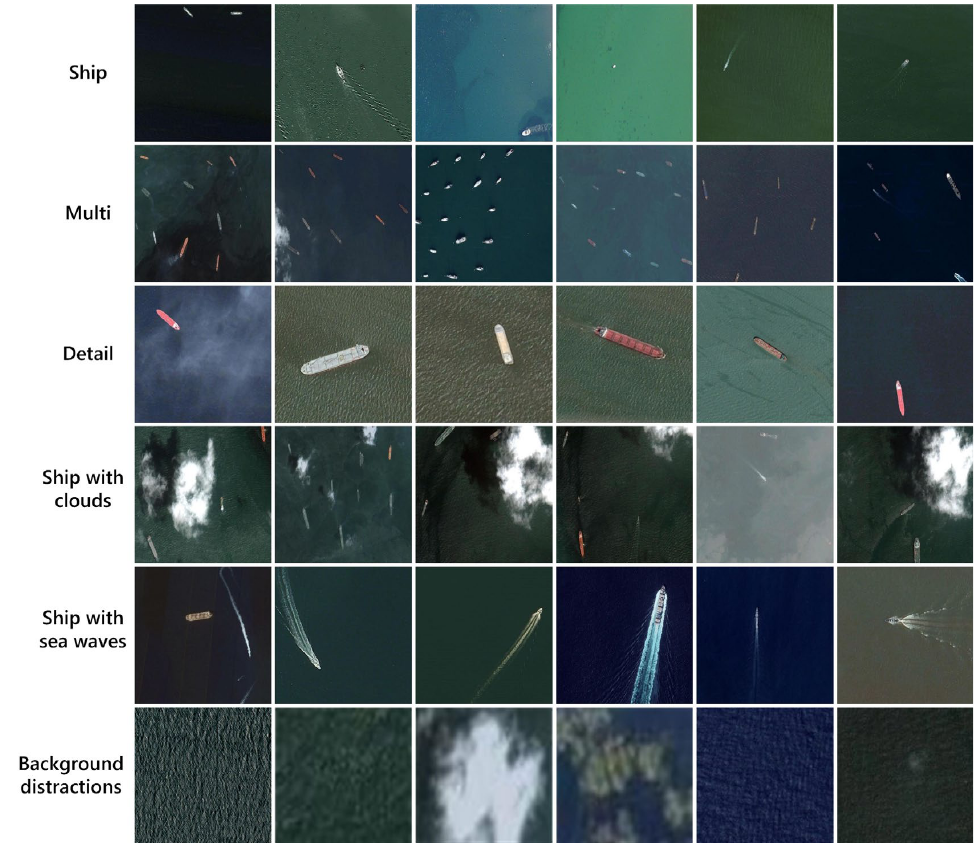
Figure 12. Image examples of different classes from the dataset. The first five rows show the ship classes, where the “detail” class is used only to enhance the training process. The last row shows some background distractions including sea waves, clouds, and islands.